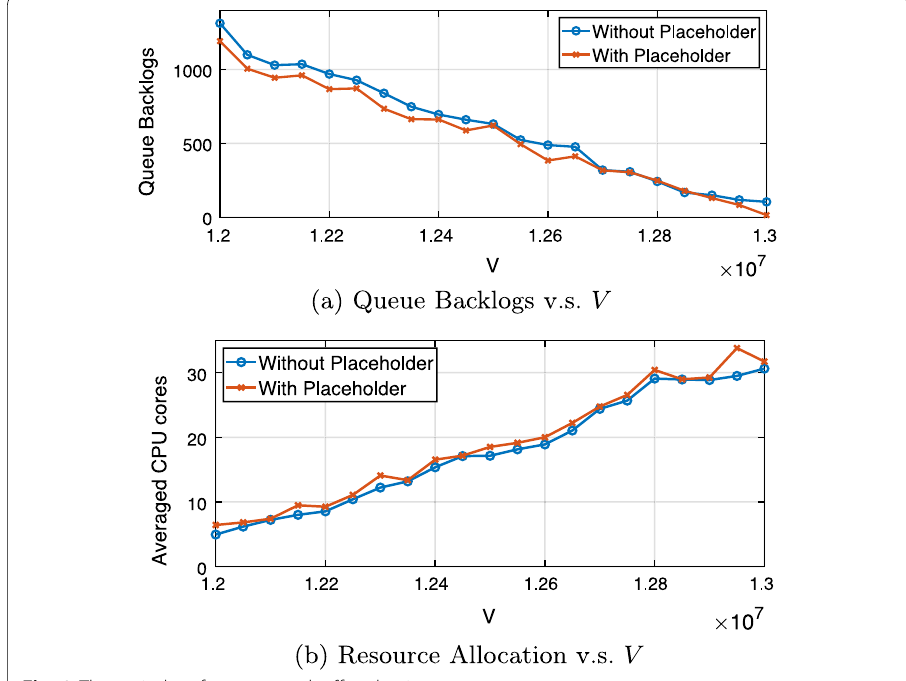
Fig. 6 Theoretical performance tradeoff